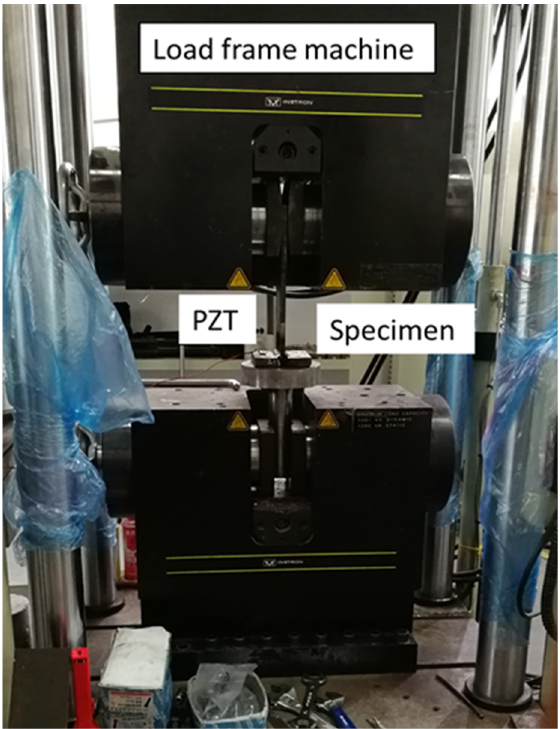
Figure 6. Experimental